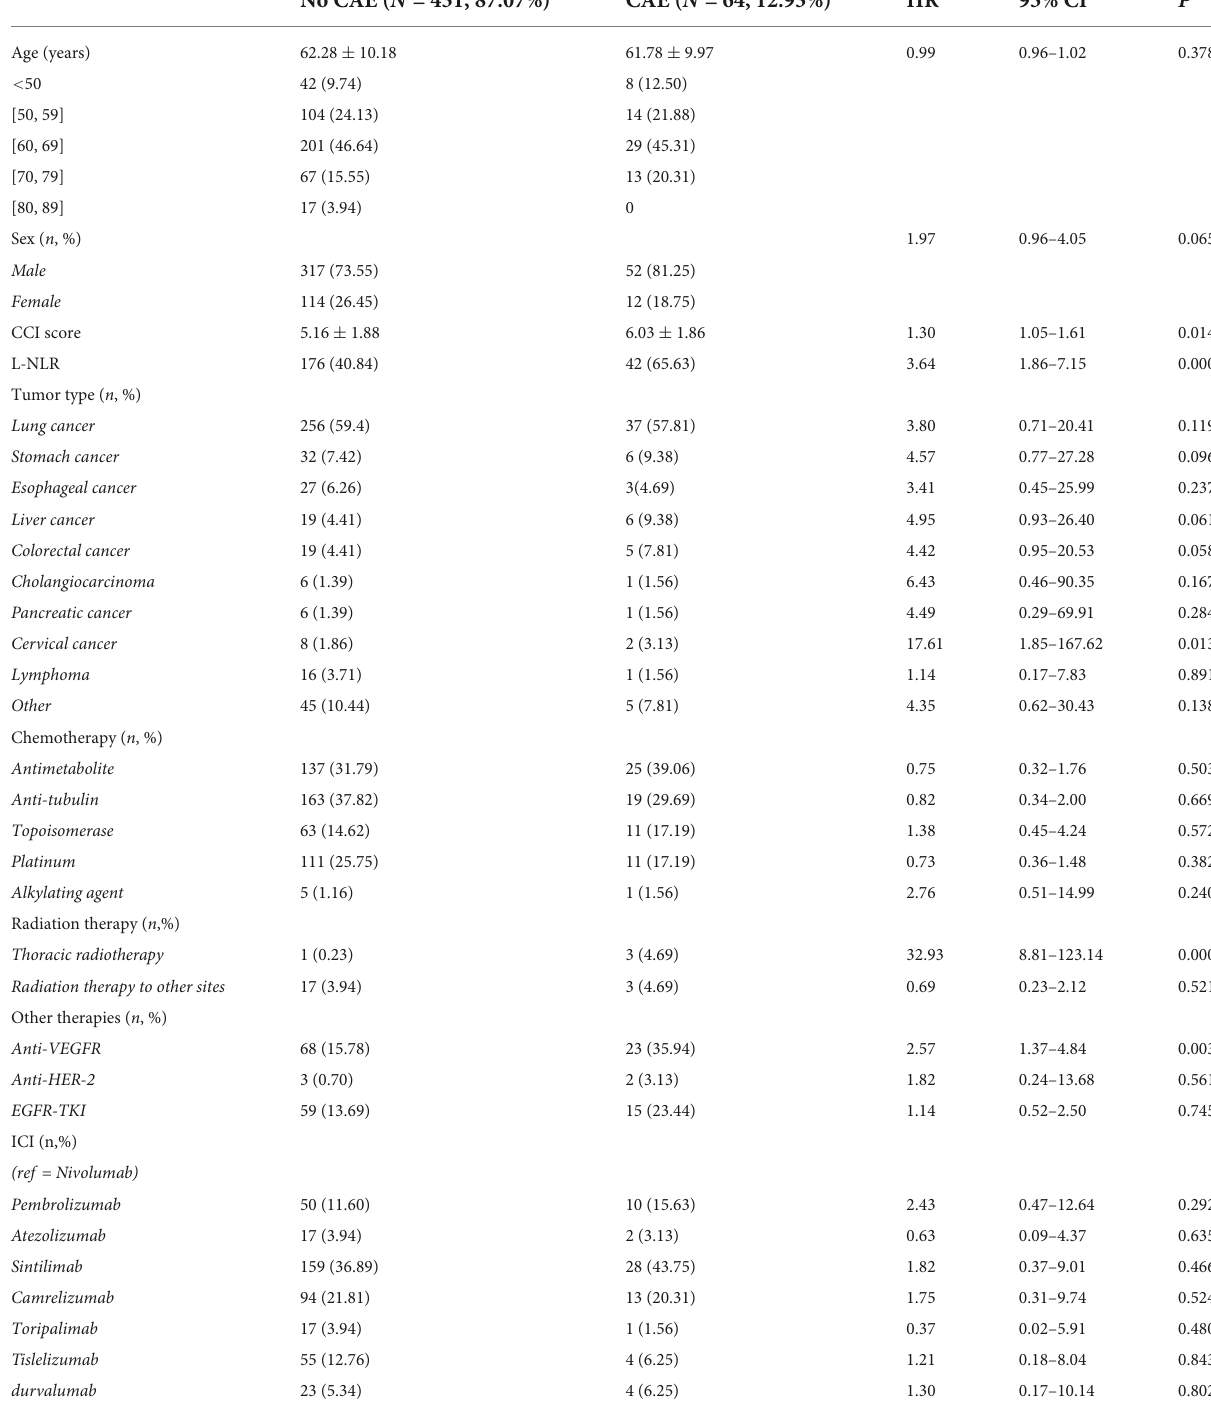
TABLE 1 The baseline characteristics of cardiac adverse events ( n =